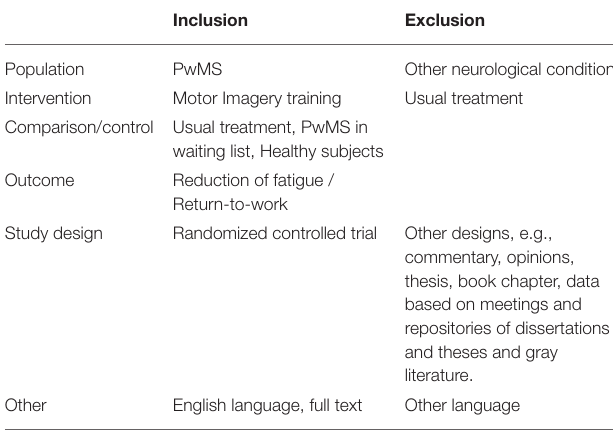
TABLE 1 | Studies selection criteria and PICO